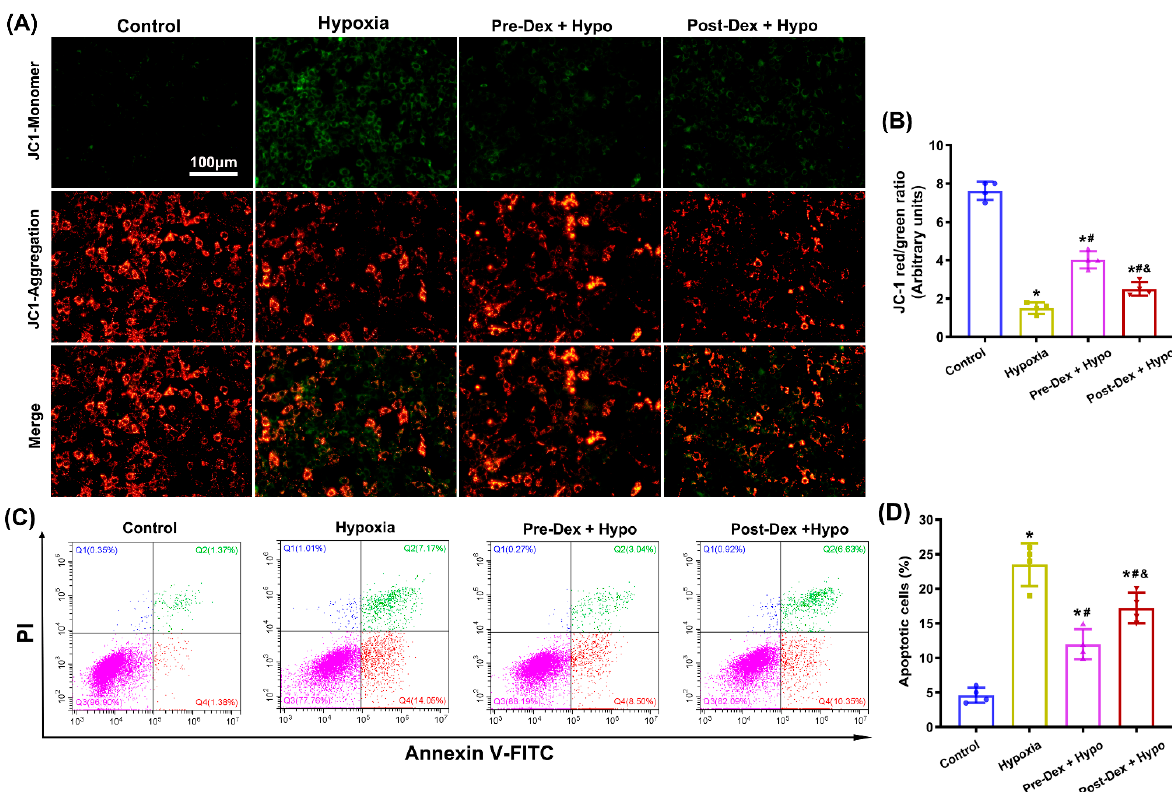
Figure 5. The effect of Dex on mitochondrial function and apoptosis in cultured hippocampal neurons following hypoxia. ( A ) Representative images of the MMP in hippocampal neurons using the mitochondrial probe JC-1. ( B ) The MMP is represented by the ratio of red to green JC-1 fluorescence. ( C , D ) Apoptosis was detected and analyzed using flow cytometry by staining cells with FITC − An- nexin V/PI. Results are expressed as mean ± SD ( n = 4 in each group). Each data point in the bar graph is also presented. * p < 0.05 versus the Control group; # p < 0.05 versus the Hypoxia group; & p < 0.05 versus the Pre-Dex group.